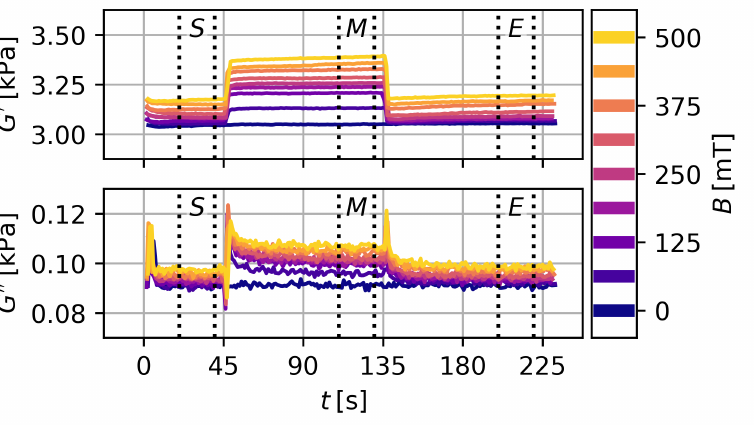
Figure 4. Storage and loss modulus over time. The magnetic field is activated at t = 45s and deactivated at t = 135s. Measurements are conducted successively with increasing magnetic flux density for a single sample. w s = 10% and T = 20°C